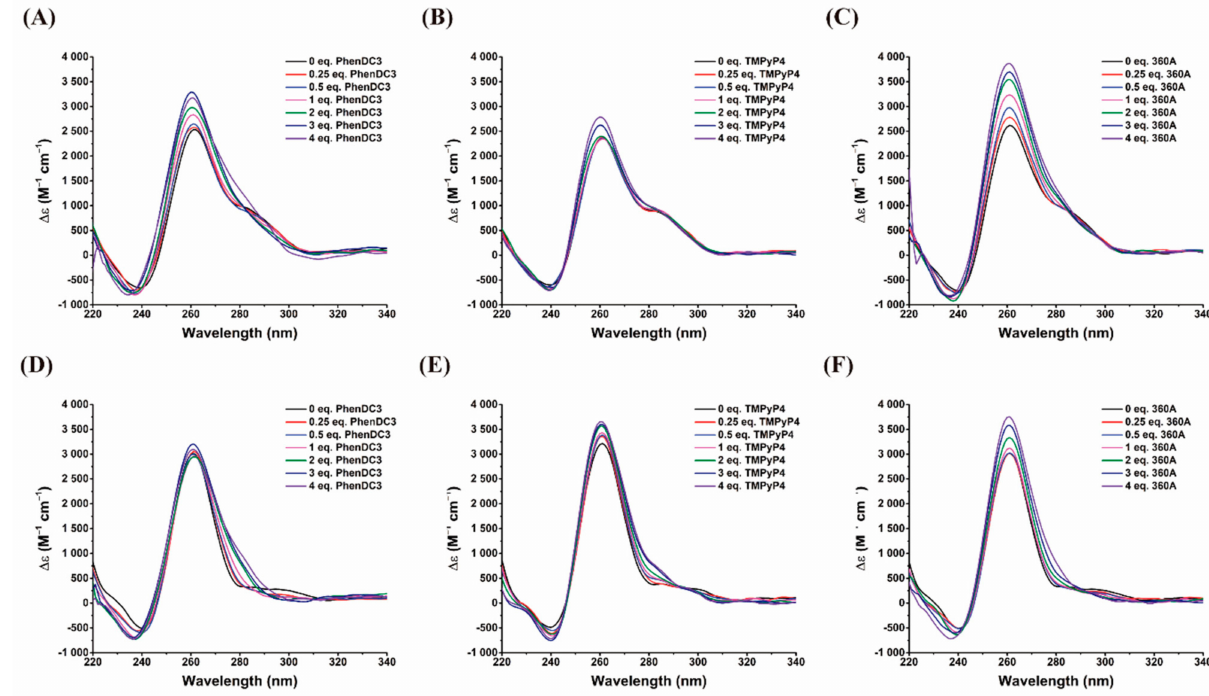
Figure 9. CD spectra of AS1411-N6 ( A – C ) and AS1411 ( D – F ) in the absence and presence of PhenDC3, 360A, and TMPyP4. Spectra were acquired in 10 mM lithium cacodylate buffer containing 140 mM